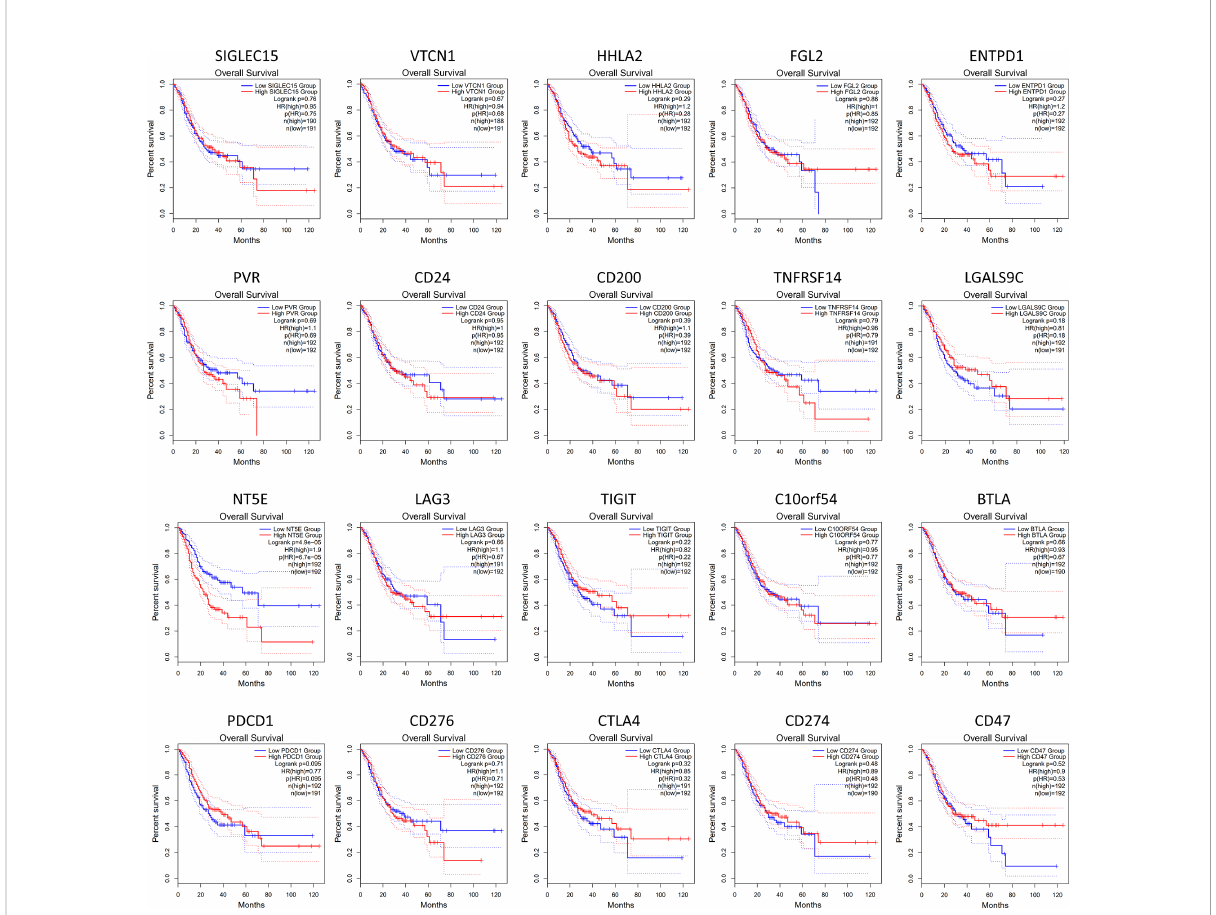
FIGURE 2 Kaplan-Meier survival curves comparing the high and low expression of immune checkpoint-related genes in GC by GEPIA database. The results showed that only the high expression of NT5E (encode CD73) was correlated with poor prognosis of GC patients (p<0.05). The red line indicates the high expression group of genes (n=192) and the blue line represents the low expression group of genes